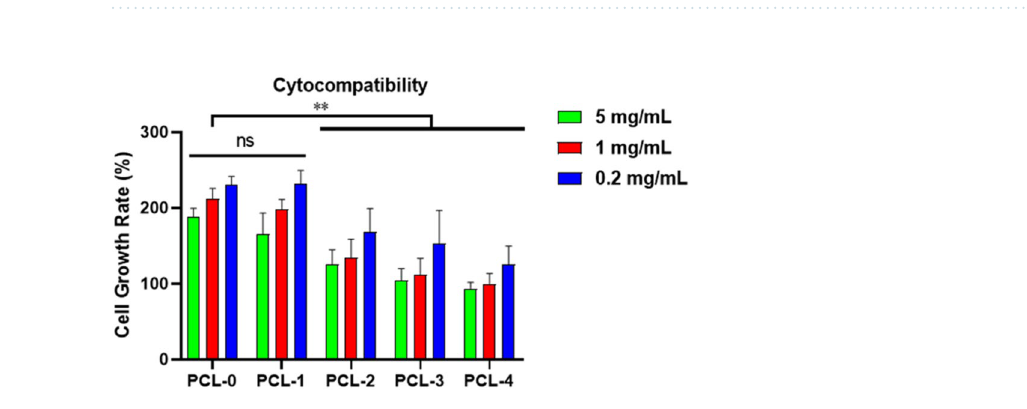
Figure 8. Antibacterial performance of PCL-based membranes against S. aureus . (Microsoft Office, PowerPoint 2010, https:// www. micro soft. com/ zh- hk/ micro soft- 365/ previ ous- versi ons/ office- 2010).